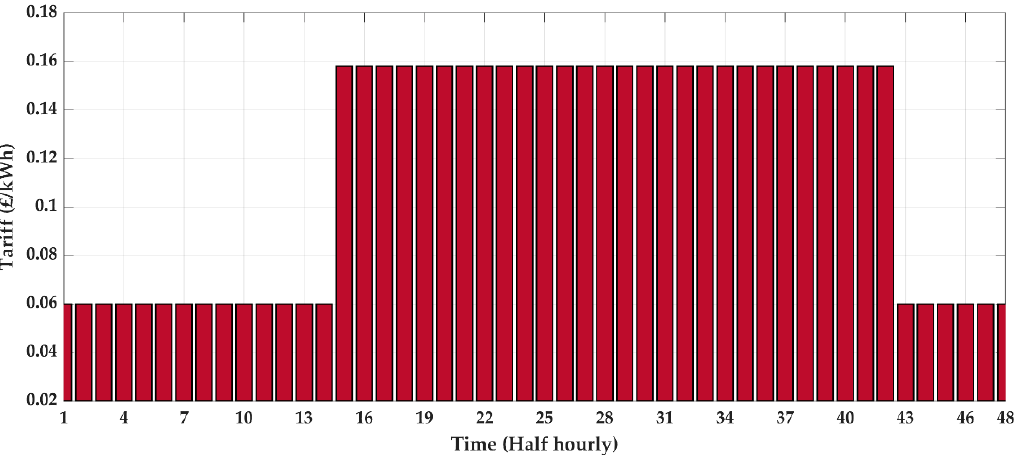
Figure 3. Economy 7 tariff.